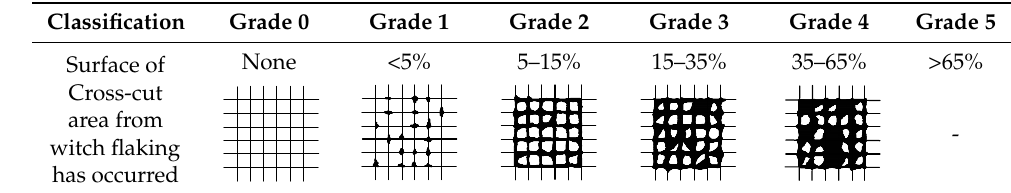
Table 1. Classification of adhesion according to the Cross-cut test. Figure 1. Classification of failure location for the Pull-off strength test.